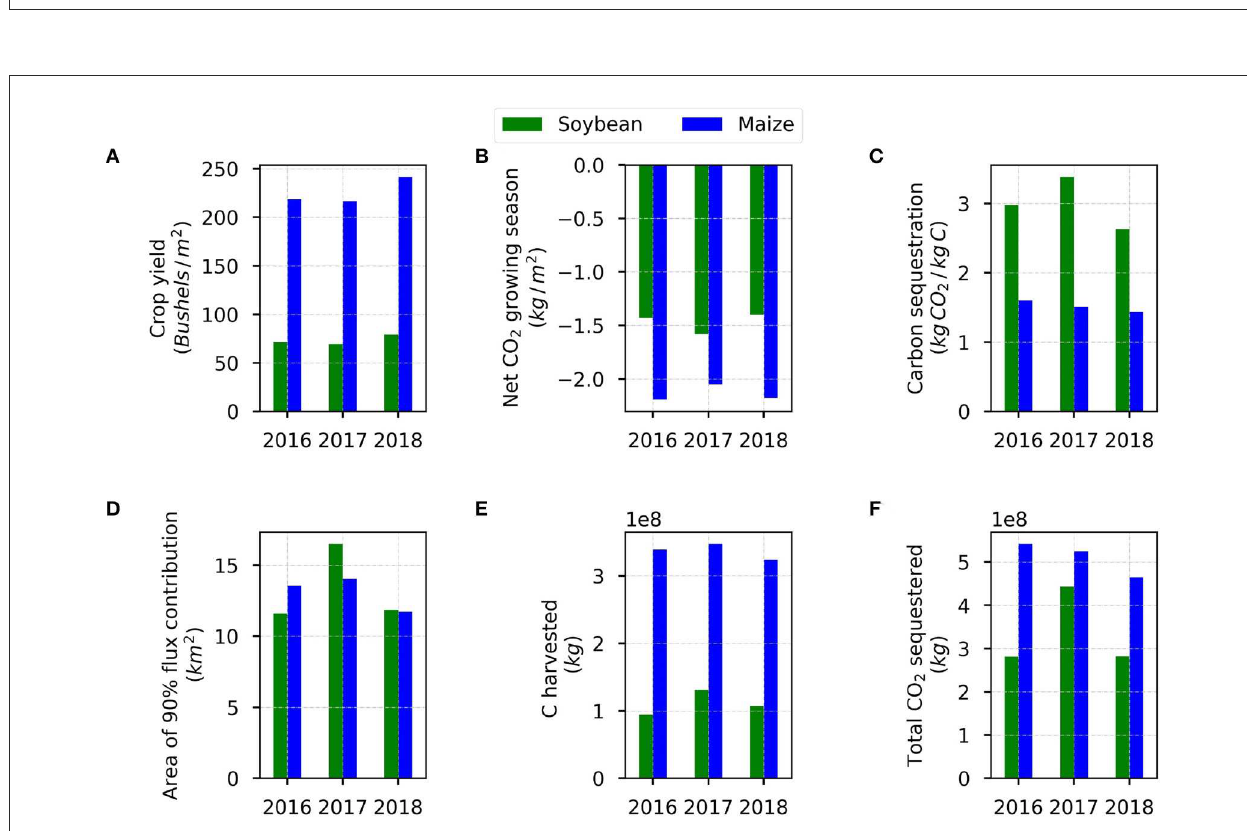
FIGURE11 Relationship between crop yield, net CO 2 during the growing season, and emissions or sequestration on a carbon basis. (A) Crop yields at Piatt county are combined with (B) the net CO 2 budget for each crop type during the growing seasons 2016–2018 estimated with MLCan, to calculate (C) the carbon sequestered for soybean and maize. (D) The climatological flux footprint area for the 90% contribution is used to calculate (E) a broad estimate of the amount of carbon that is harvested and (F) of the amount of CO 2 sequestered by each crop inside the flux